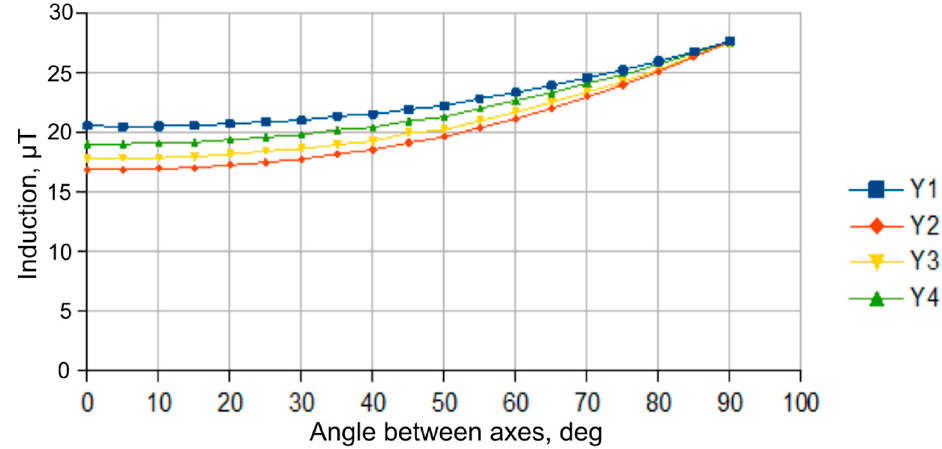
Figure 12. Dependence of Y component of the magnetic induction vector in the cores of magneto- sensitive elements (Y1 − Y4 curves correspond to D1 − D4 sensors) with the shield longitudinal axis and power cable axis arranged in the same plane.